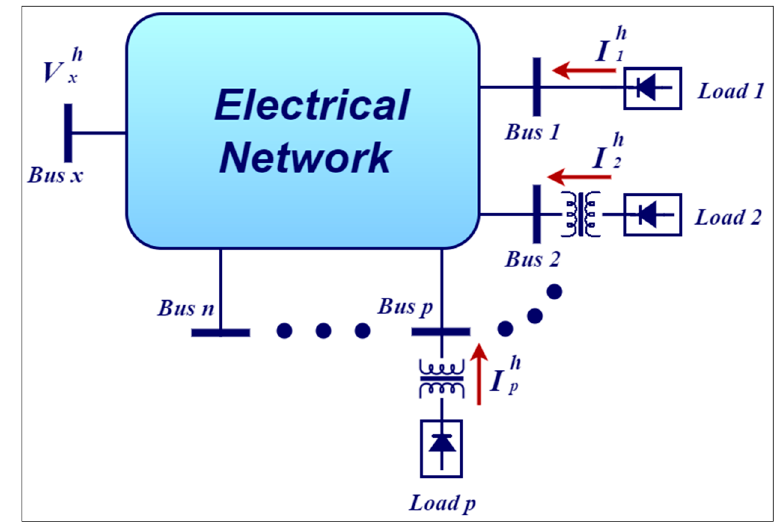
Figure 1. A generic electrical power system, adapted from [18].